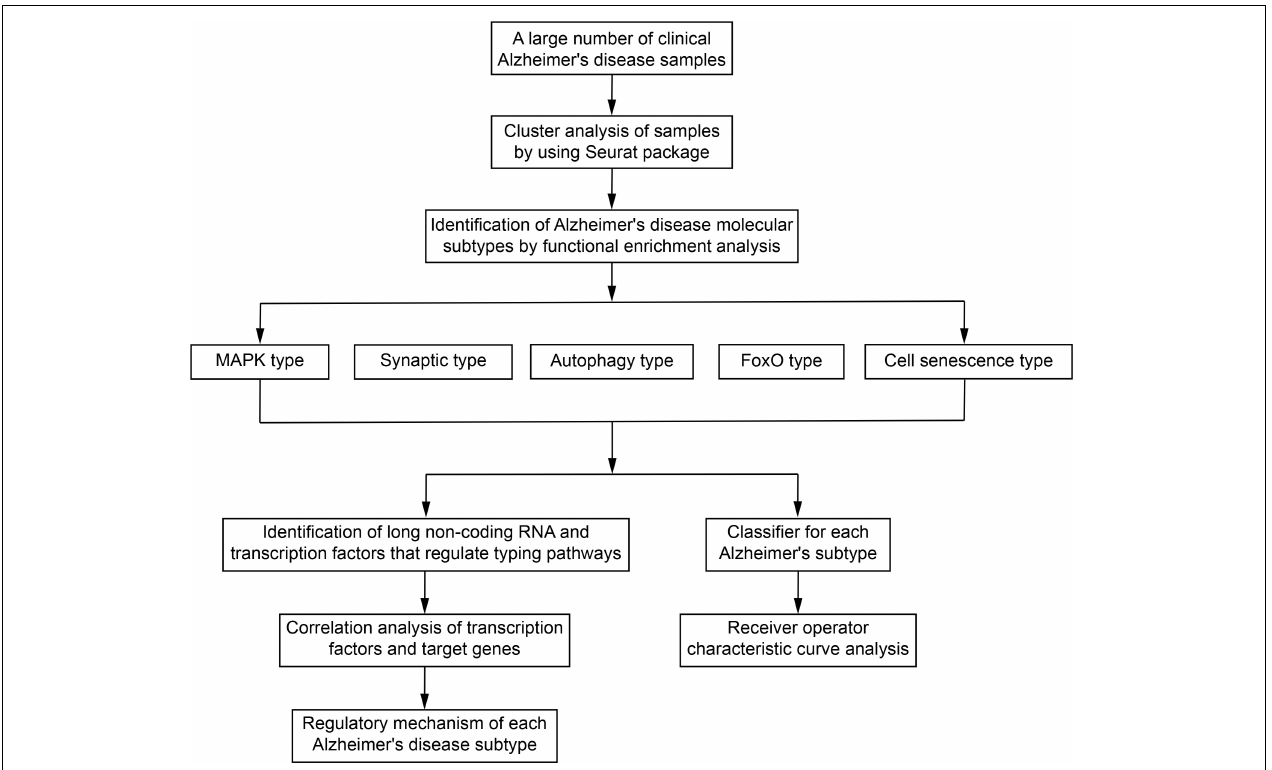
FIGURE 1 | Study flowchart. MAPK, mitogen-activated protein kinase; FoxO, forkhead box class